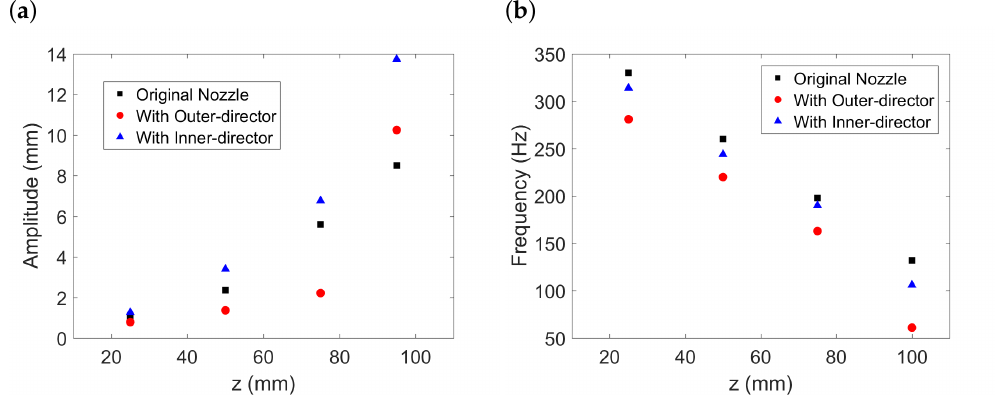
Figure 10. ( a ) Fibre oscillation amplitude along z and ( b ) fibre oscillation frequency along z